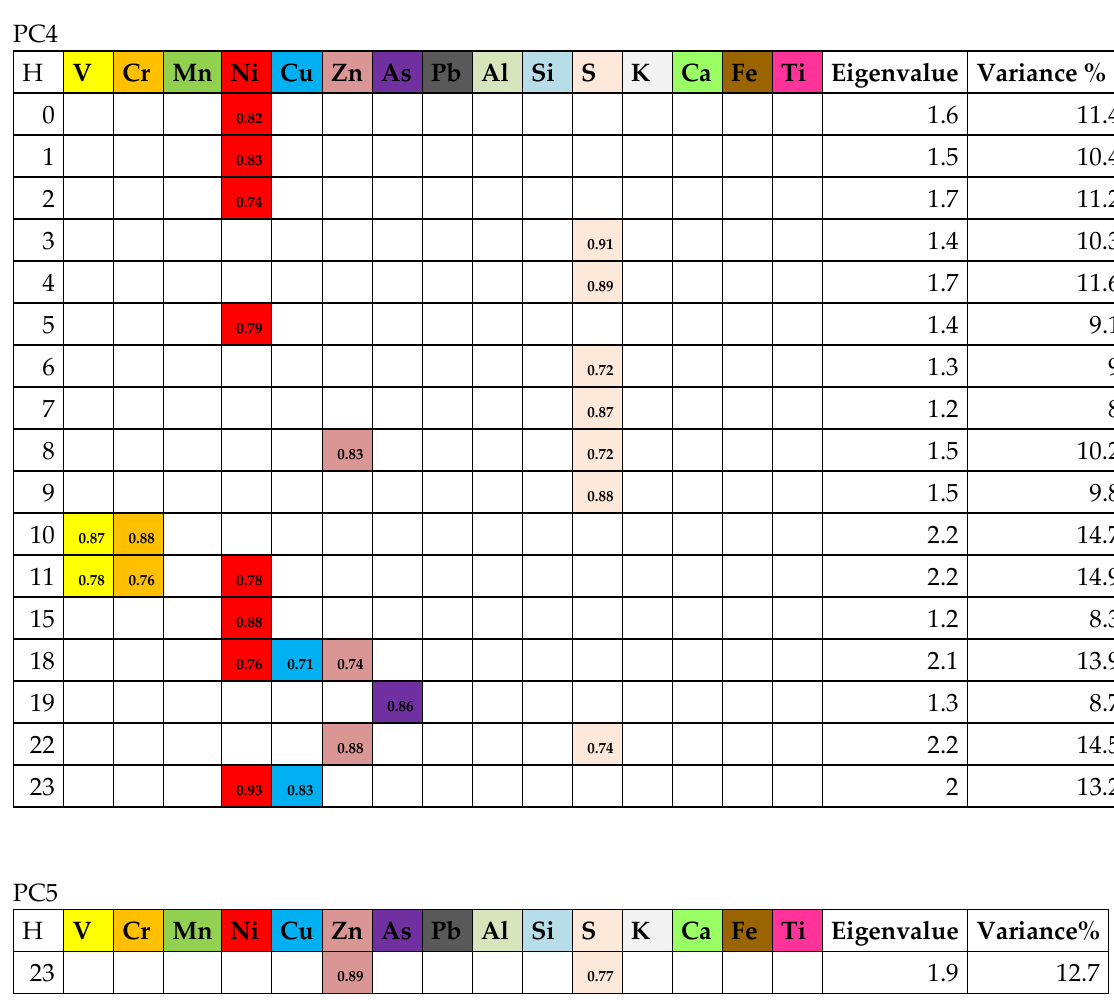
Figure 5. A summary of the results of the principal component analysis (PCA) performed on hourly data on the elemental composition of PM 10 . For each hour, 29 data were used, and the tables summarized only those elements that were always correlated with the variables PC1–PC5 (correlation coefficient r > 0.7).